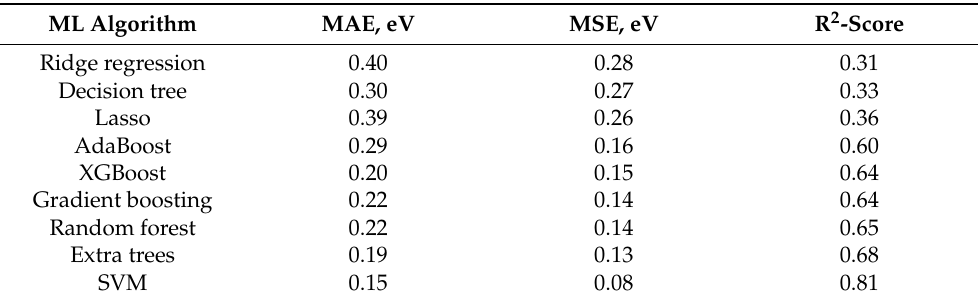
Table 1. Comparison of the used ML algorithms in terms of their efficiency for predicting the binding energy over the entire interval of the calculated